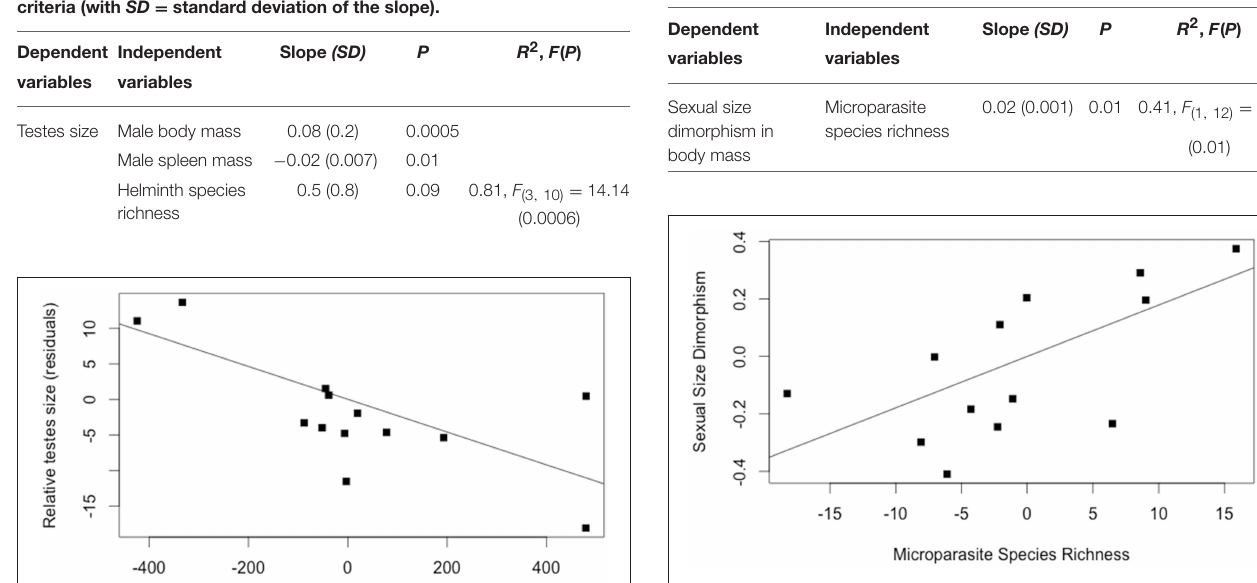
TABLE 5 | Best model explaining sexual size dimorphism in rodent species using independent contrasts (initial model with relative spleen mass, helminth species richness, microparasite species richness, relative testis size and habitat centrality) using the AIC criteria (with SD = standard deviation of the slope).